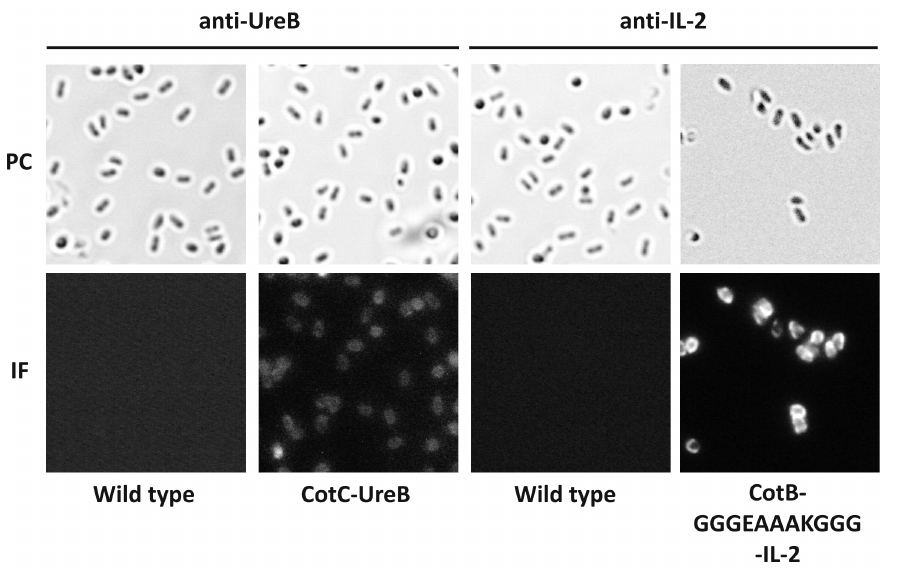
Figure 5. Localisation of fusion proteins as assessed by immunofluorescence microscopy. Purified, free spores of wild type strain 168, BKH108 (CotC-UreB), BKH122 (CotB- GGGEAAAKGGG -IL-2) were visualised by phase contrast (PC) and immunofluorescence (IF) microscopy. The spores were incubated with mouse anti-UreB or anti-IL-2 antibodies, followed by anti-mouse IgG-Cy3 conjugates. The same exposure time was used for all IF images.